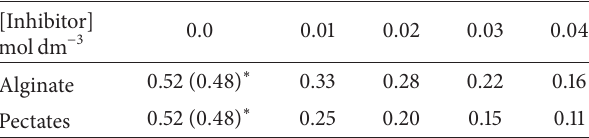
Figure 2: A typical plot of the weight-loss versus time for corrosion of Al in alkaline media in absence of inhibitors at 30 ∘ C. [OH − ] = 4.0 moldm −3 . Table 1: The corrosion rates ( 𝑅 𝑐 ) for corrosion of Al in alkaline media in absence and presence of inhibitors. [OH − ] = 4.0 and I = 4.0 moldm − 3 at 30 ∘ C.